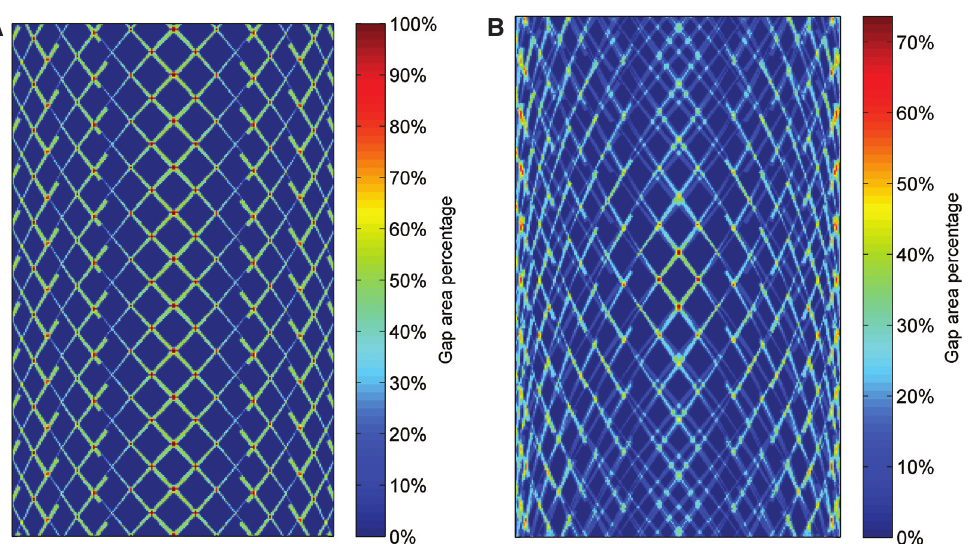
Figure 6 Gap distribution within the laminate averaged through the